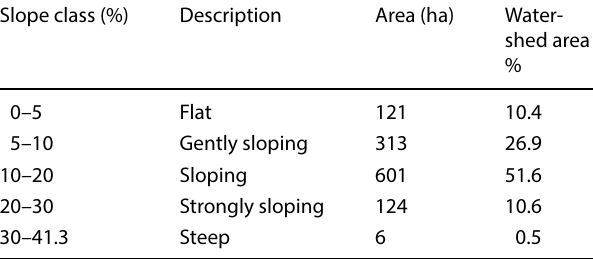
Table 2 Slope classes of the watershed based on FAO classification Slope class